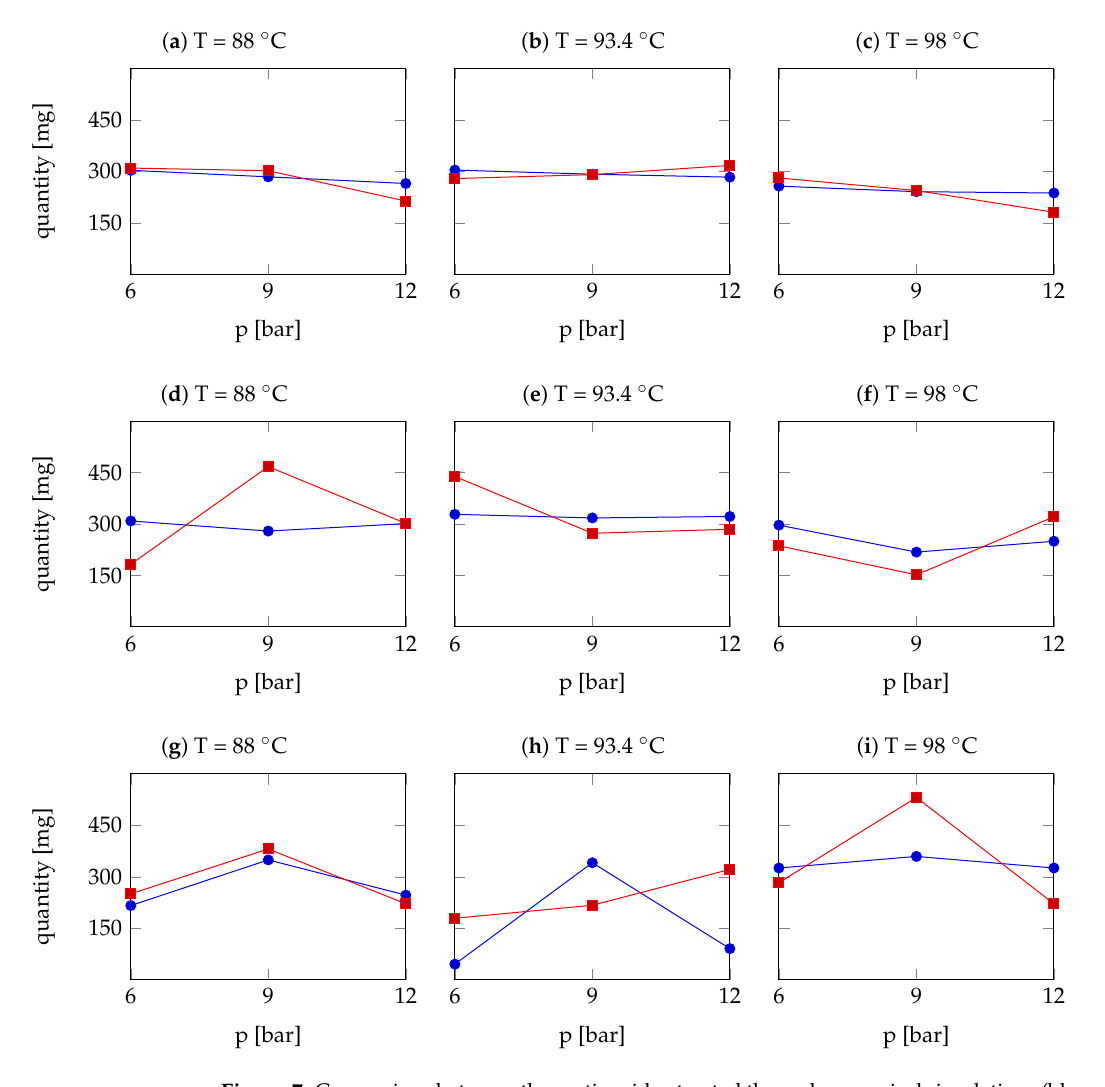
Figure 7. Comparison between the acetic acid extracted through numerical simulations (blue profile with circles) and laboratory measurements (red profile with squares), with different inlet water temperatures and pressures and different grain size of Arabica coffee powder. Figures ( a – c ) show the results of optimal granulometry, Figures ( d – f ) of coarse granulometry and Figures ( g – i ) of fine granulometry.